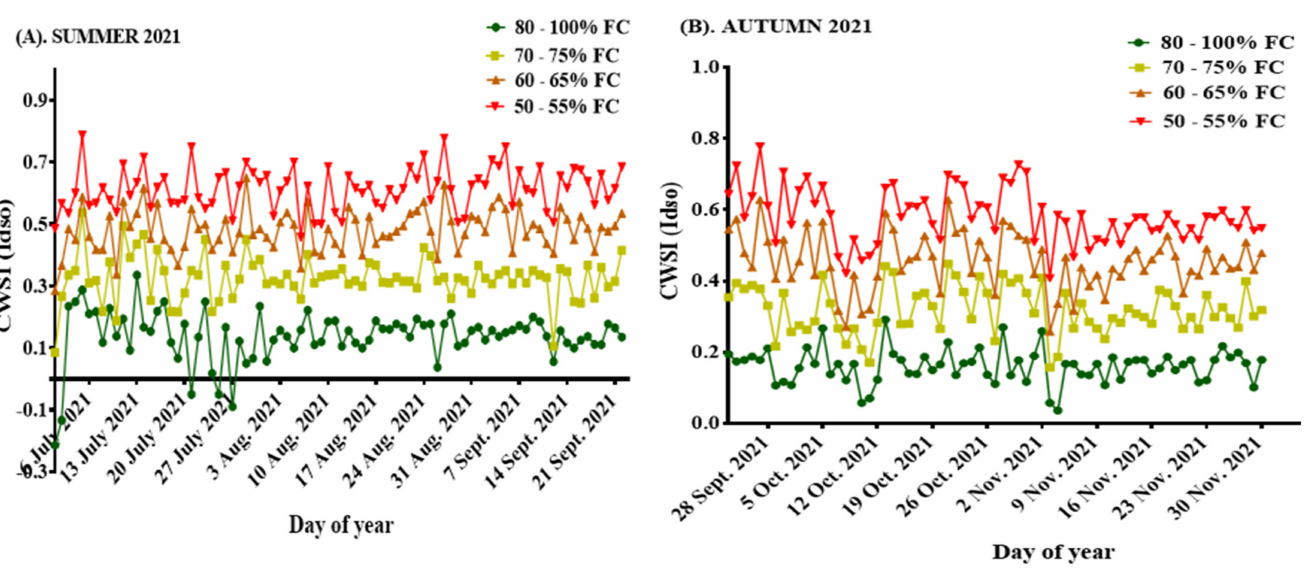
Figure 7. ( A ) CWSI for summer 2021; ( B ) CWSI for autumn 2021. Both the VPD and the measured canopy-air temperature differences were significantly different (at p < 0.001) among the treatments and within treatments; however, both pa- rameters were strongly correlated to the CWSI, as determined from the Idso procedures at R 2 = 0.67 and R 2 = 0.79, respectively, as shown in Figure